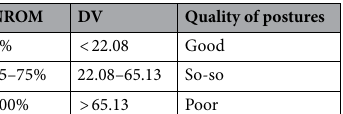
Table 4. A relationship between the back flexion NROM, DV and quality of postures 17,19